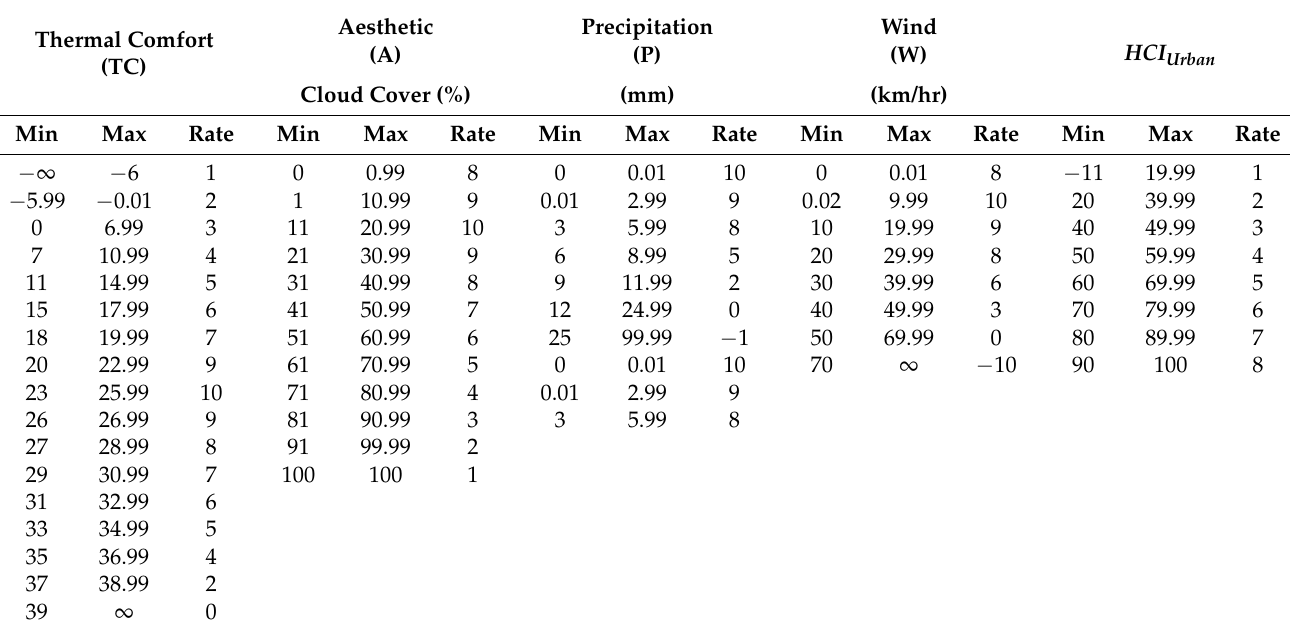
Table A2. The ratings of thermal comfort, aesthetics (according to cloud cover), precipitation, wind facets, and HCI urban scores.